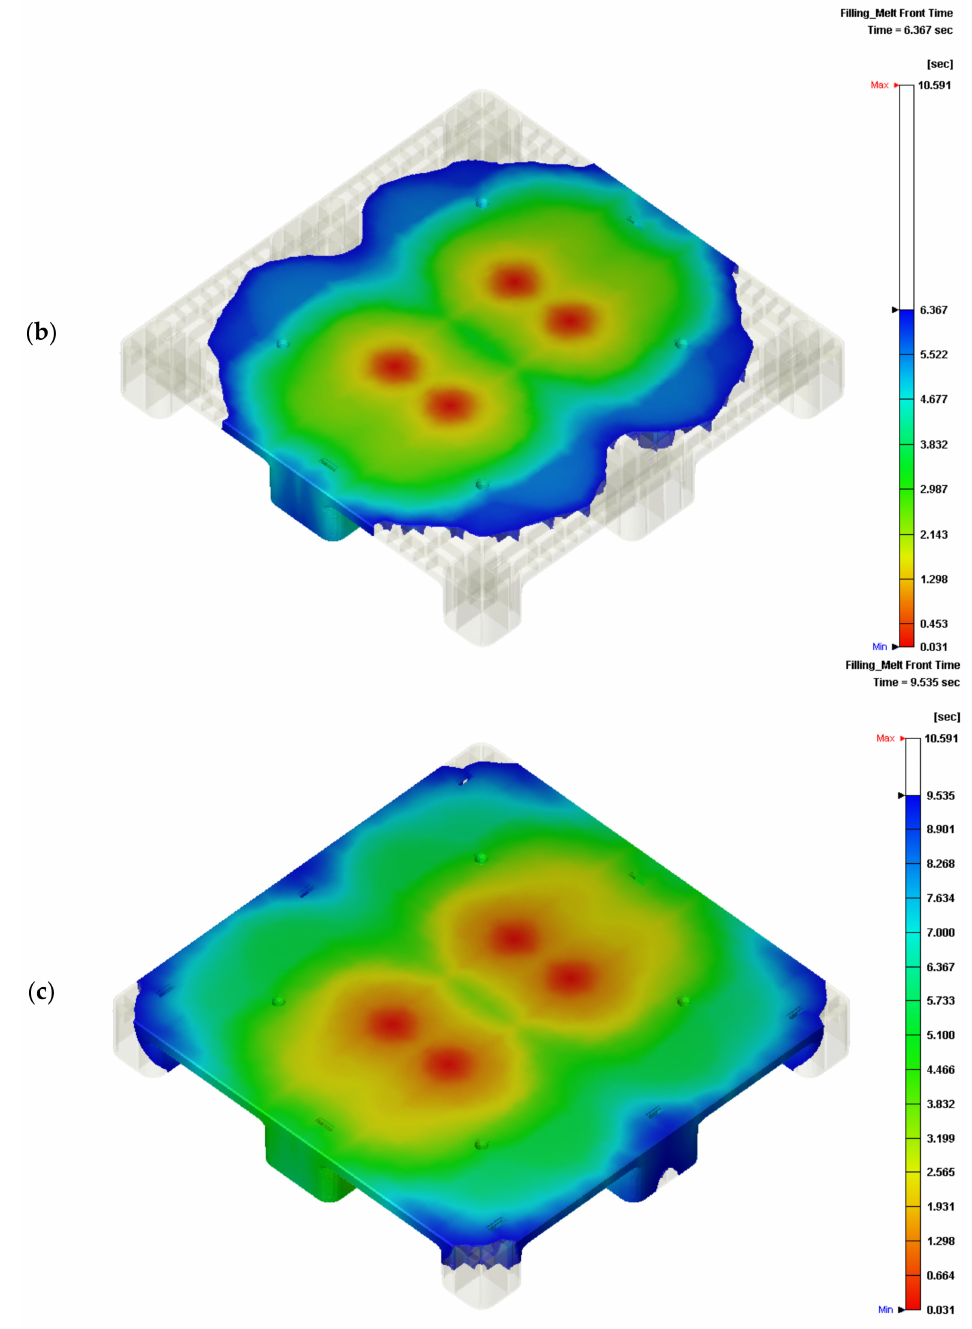
Figure 5. Flow front under the proposed sequential valve gate scheme: ( a ) 30% of total filling; ( b ) 60% of total filling; ( c ) 90% of total